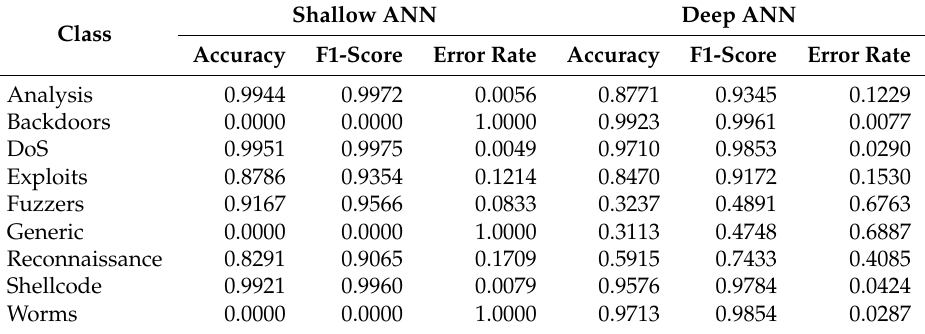
Table 5. Error rate for Type-A binary class models using the UNSW-NB15 dataset.